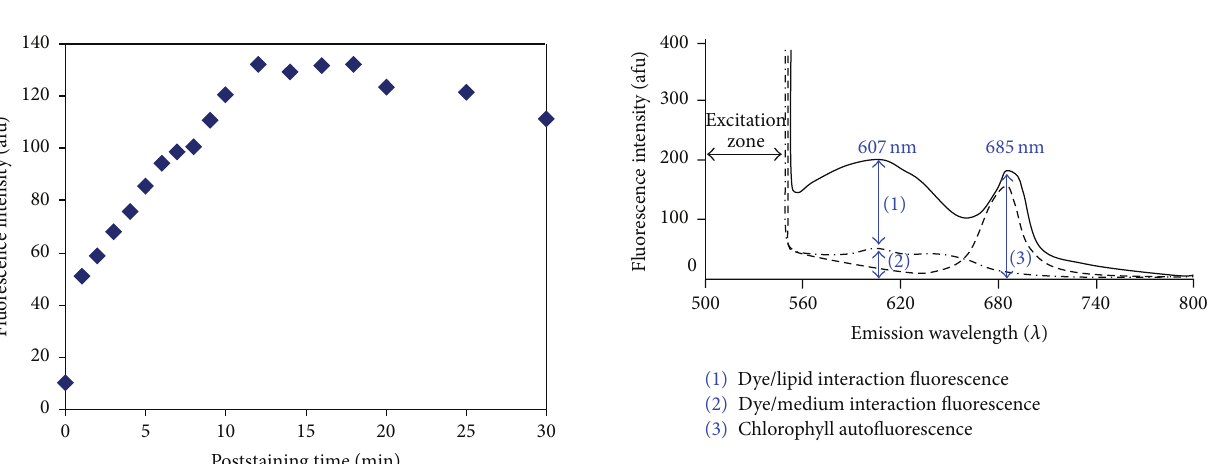
Figure 3: Emission spectra of three different experiments from the factorial experimental design (Table 2). Excitation wavelength = 530 nm. For convenience, real values (instead of coded values) of the independent variables are shown below. For all three experiments, ultrasonication power = 0 W, incubation temperature = 20 ∘ C, and poststaining time = 15min. —: experiment 29 (stained microalgal culture); cell concentration = 0.11g dried microalgae/L culture and Nile red dye concentration = 2.5 𝜇 g dye/mL culture. - ⋅ - ⋅ - ⋅ : experiment 2 (stained growth medium); cell concentration = 0 g dried microalgae/L culture and Nile red dye concentration = 2.5 𝜇 g dye/mL culture. -----: experiment 28 (unstained microalgal culture); cell concentration = 0.11g dried microalgae/L culture and Nile red dye concentration = 0 𝜇 g dye/mL